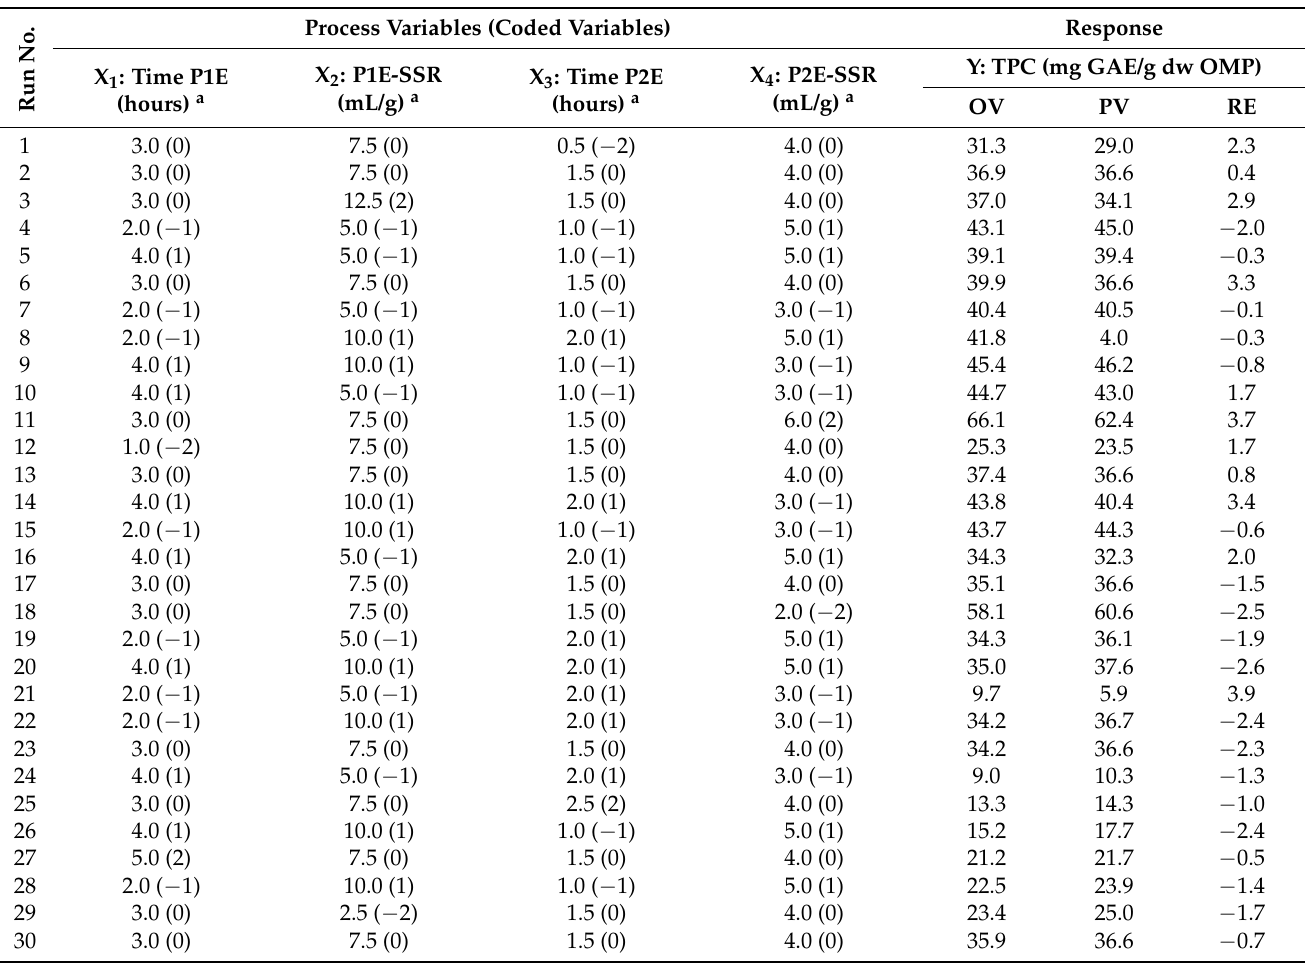
Table 1. Experimental design for the optimization of the extraction of antioxidants and phenolic compounds from olive mill